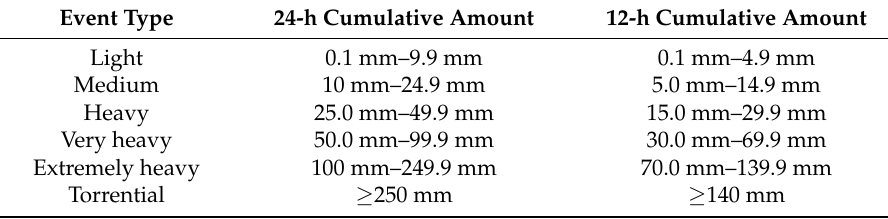
Table 1. Classification criteria of rainfall-runoff